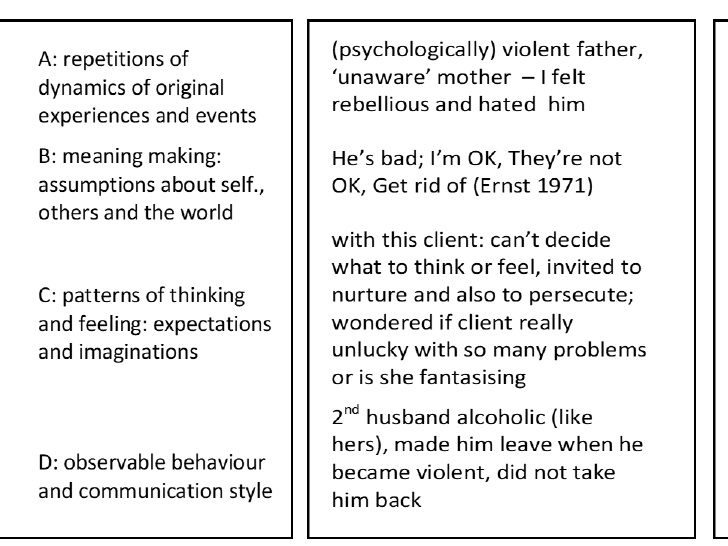
Figure 31: Comparative Script System (Sills & Mazzetti, 2009 p. 306)